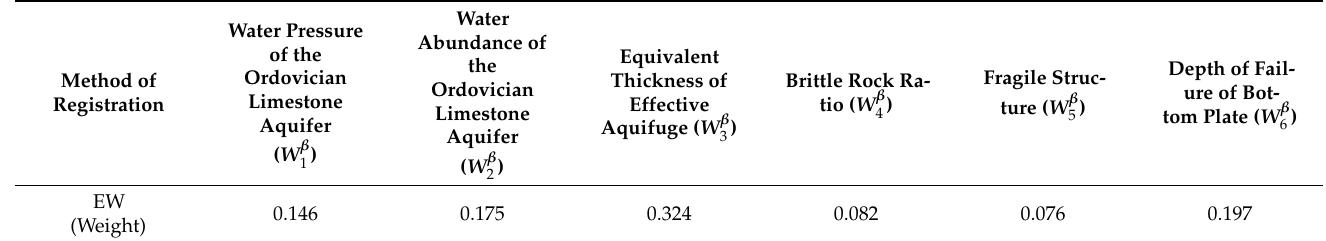
Table 3. Entropy Weight Method to Determine the Weight Results of the Main Controlling Factors.